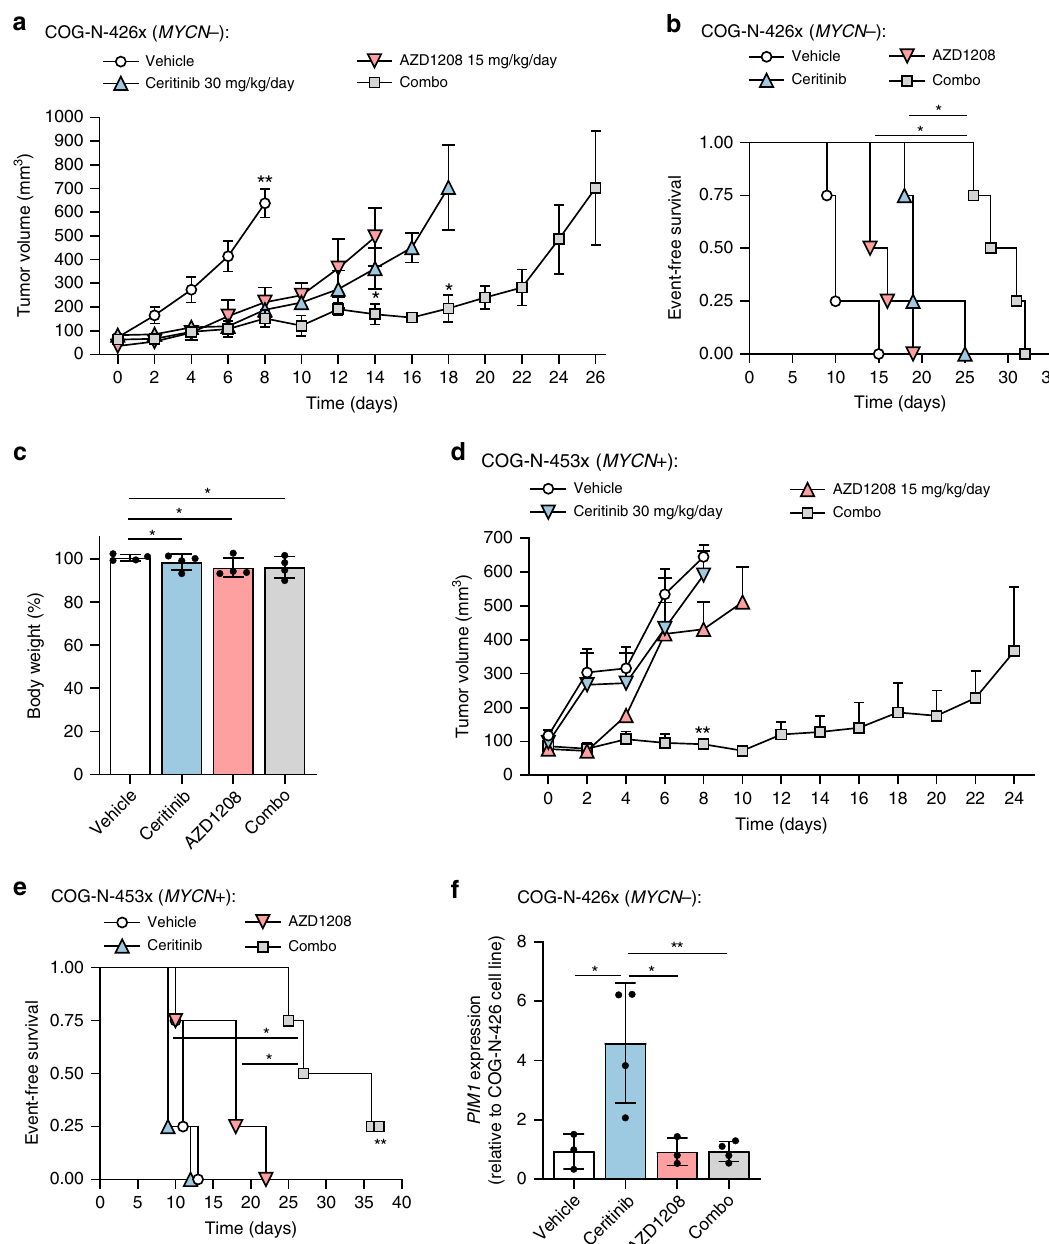
Fig. 5 Ef fi cacy of ceritinib and AZD1208 in driven patient-derived NB xenografts. a Tumor volume over time in COG-N-426x PDX mice administered daily with vehicle (0.5% hydroxypropyl methylcellulose, 0.5% Tween-80), ceritinib (30 mg/kg), AZD1208 (15 mg/kg), or ceritinib and AZD1208 (combo). Data points represent means ( n = 4) ± s.e.m. and are shown until death of the fi rst animal within each treatment group. * p < 0.05; ** p < 0.005 (Mann – Whitney test). b Kaplan – Meier event-free survival according to each treatment group for tumor-bearing COG-N-426x mice, where survival is de fi ned as the time taken for tumors to reach 15 mm diameter. * p < 0.01 (Log-rank test). c COG-N-426x mouse body weight at the experiment end-point relative to